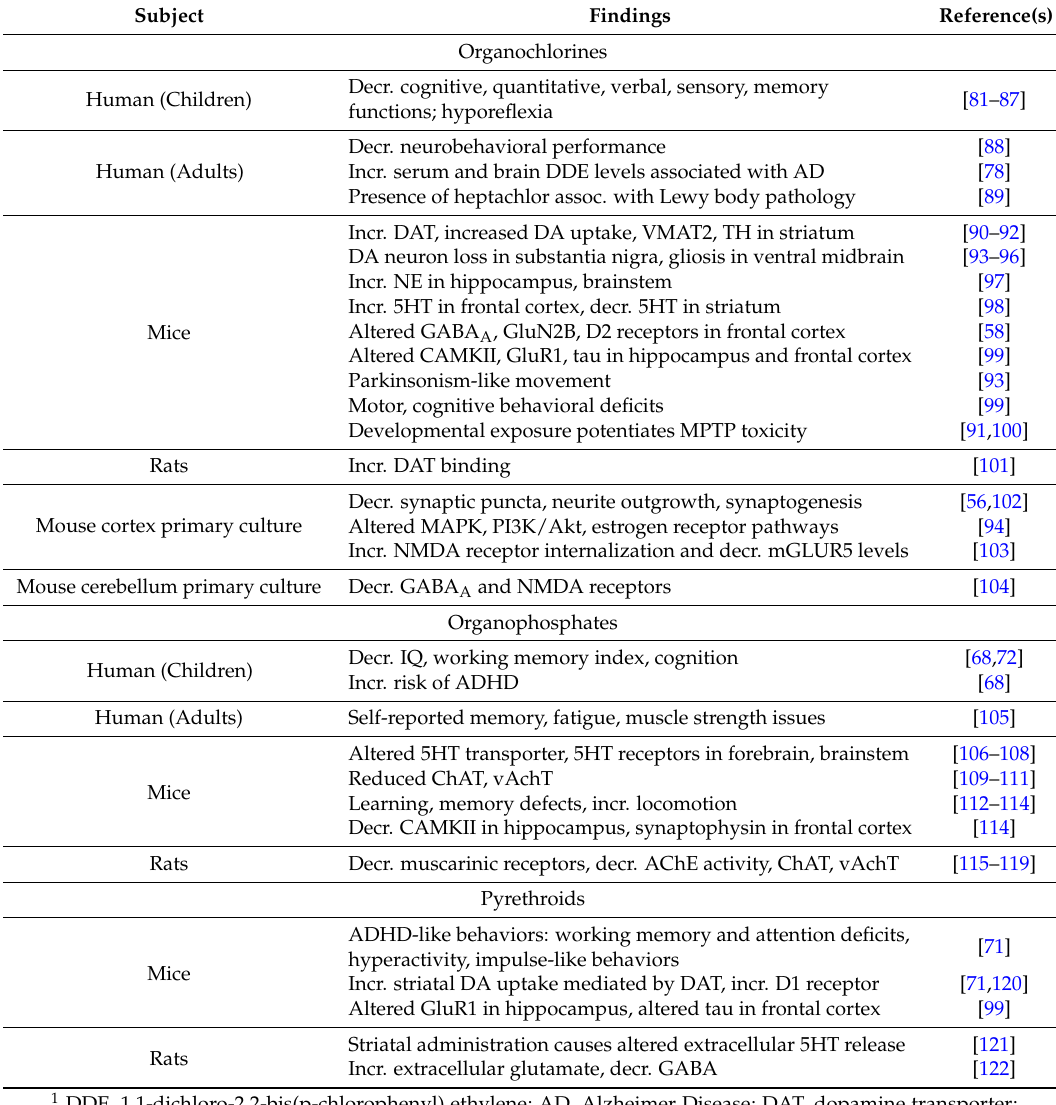
Table 1. Studies associating pesticide exposure and neurologic function 1